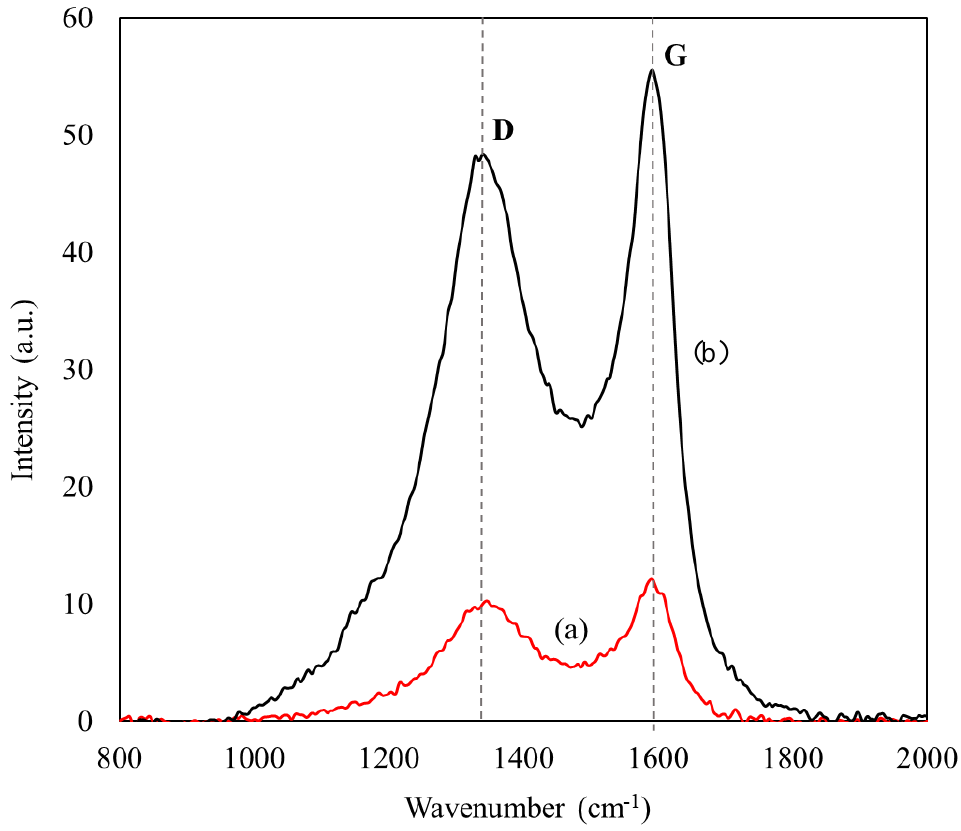
Figure 3. Raman spectra of (a) CX-4 and (b) ASNase-CX-4 bioconjugate. Table 2. Band D and G intensities of CXs and ASNase-CX bioconjugate calculated from Raman spectra.